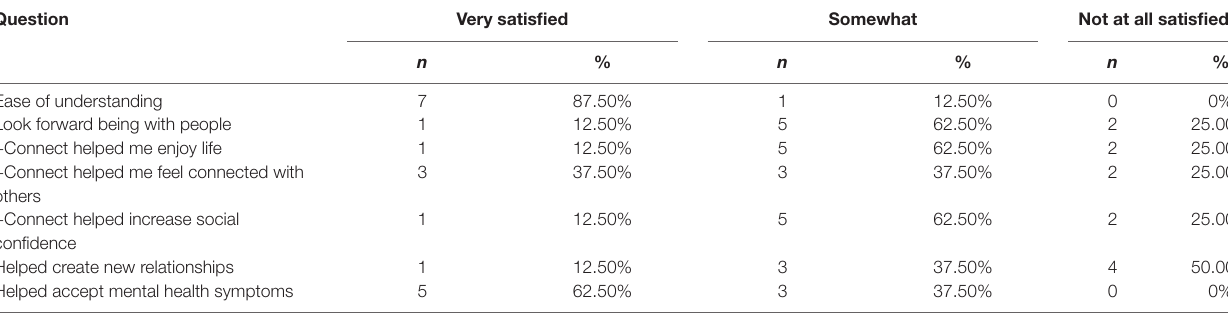
TABLE 5 | Post-intervention outcome ratings of the +Connect for the SAD group.